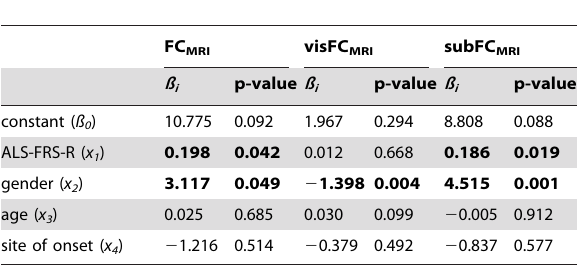
Table 2. Results of multiple linear regression